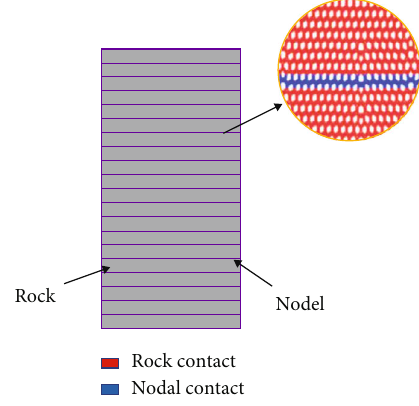
Figure 4: Di ff erent contact types in jointed rock